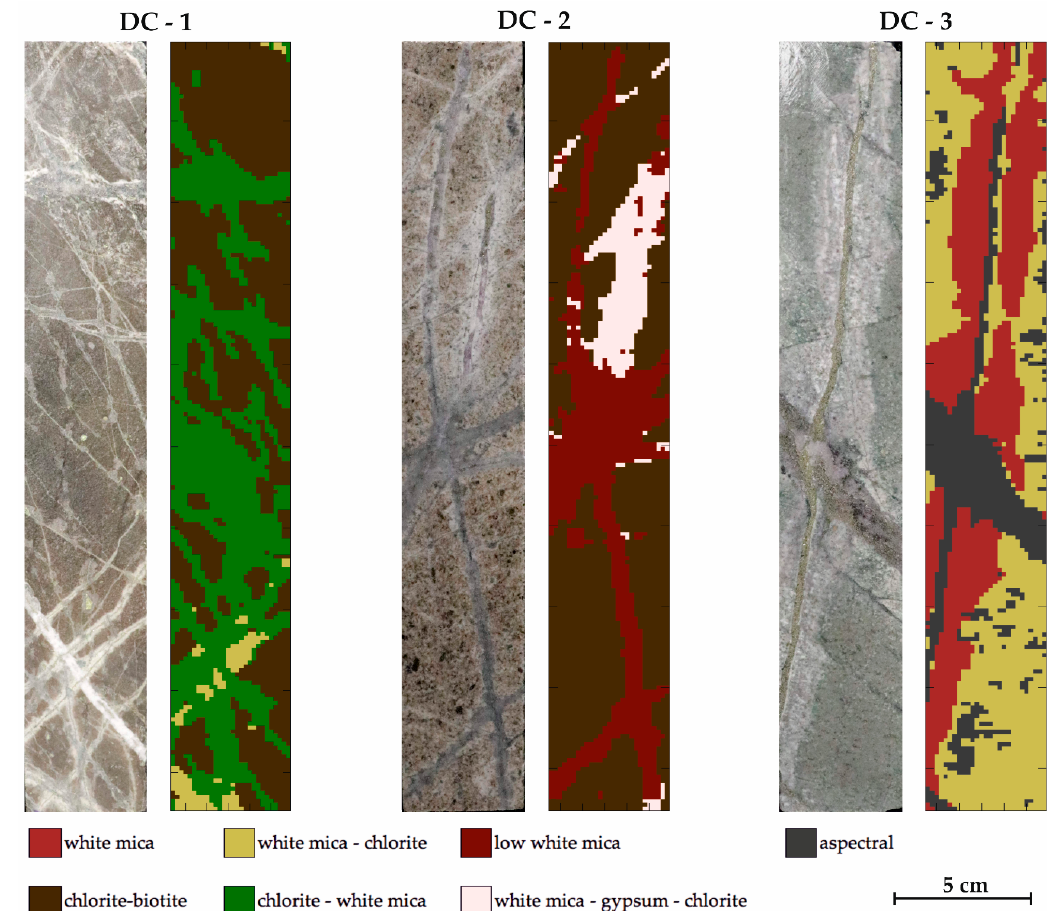
Figure 7. RGB image of the drill core samples and mineral maps obtained from N-Findr, FC-LSU and maximum abundance mapping using 3 endmembers.